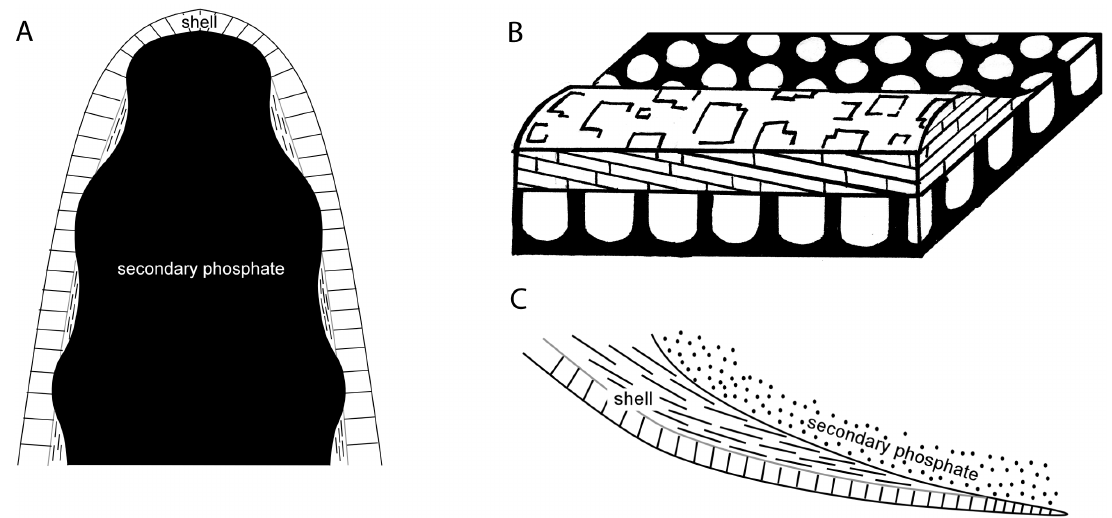
Fig. 1. Shell microstructure patterns in Mackinnonia and stenothecids. A , cross-sectional view of Mackinnonia fossils, showing how troughs in the internal mould express the inner shell layer while ridges express the outer shell layer. B , general microstructure pattern of stenothecids and Mackinnonia with a prismatic outer layer and calcitic semi-nacre inner layer. Outer shell surface is at the bottom. C , sectional view of Mellopegma and other molluscs where the shell margin thins and expresses the outer shell layer on the inner shell surface. Outer shell surface is at the bottom.